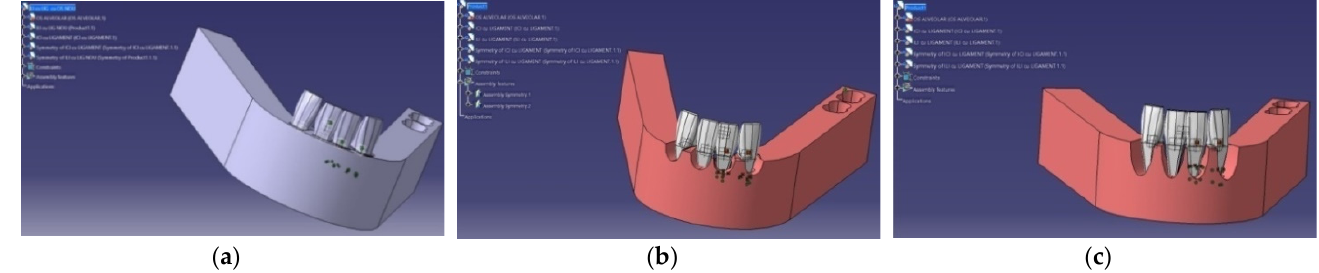
Figure 1. ( a ) Mandibular model with no periodontal damage, ( b ) mandibular model with 33% periodontal damage, and ( c ) 66% periodontal damage. Table 2. Material characteristics.